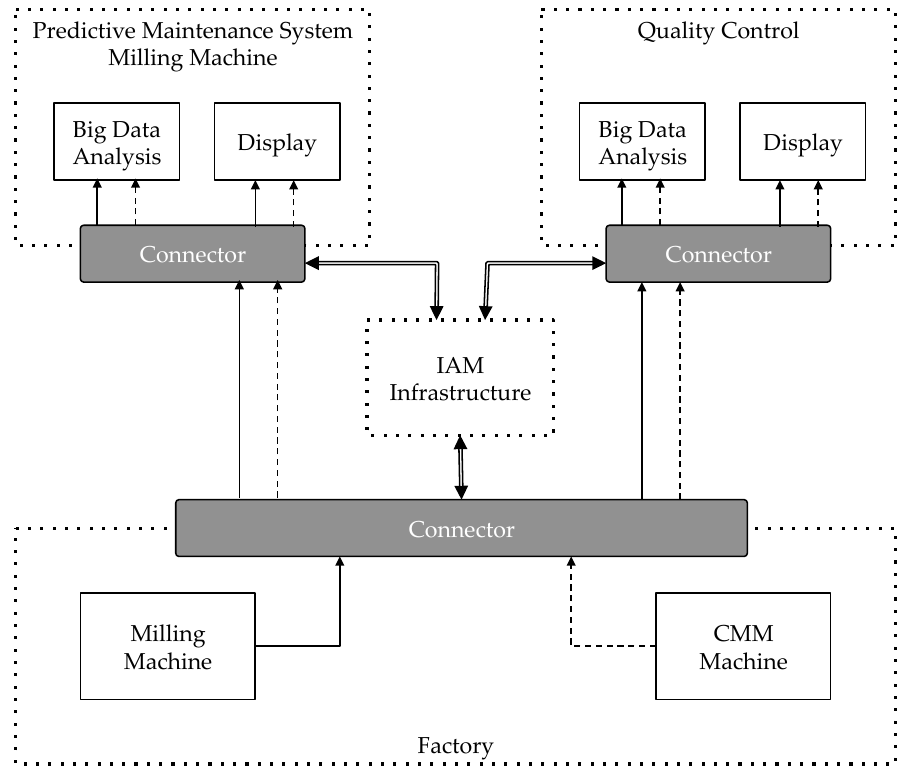
Figure 6. Use case modules and